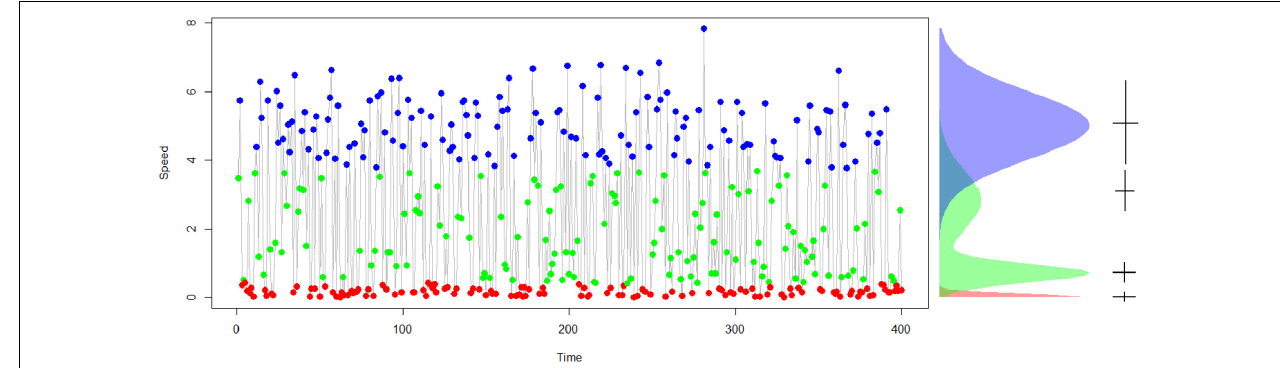
FIGURE 2 | Recovery of vessel behavior states and speed distributions from simulated data using our hidden Markov model. The left panel shows simulated data from the VMS system over time, with variations in vessel speeds driven by the state of the vessel. The colors of the points show the estimated states of the vessel, using an HMM to model the speed distribution and state transitions. The right panel shows the distribution of speeds estimated for each of the three states in the